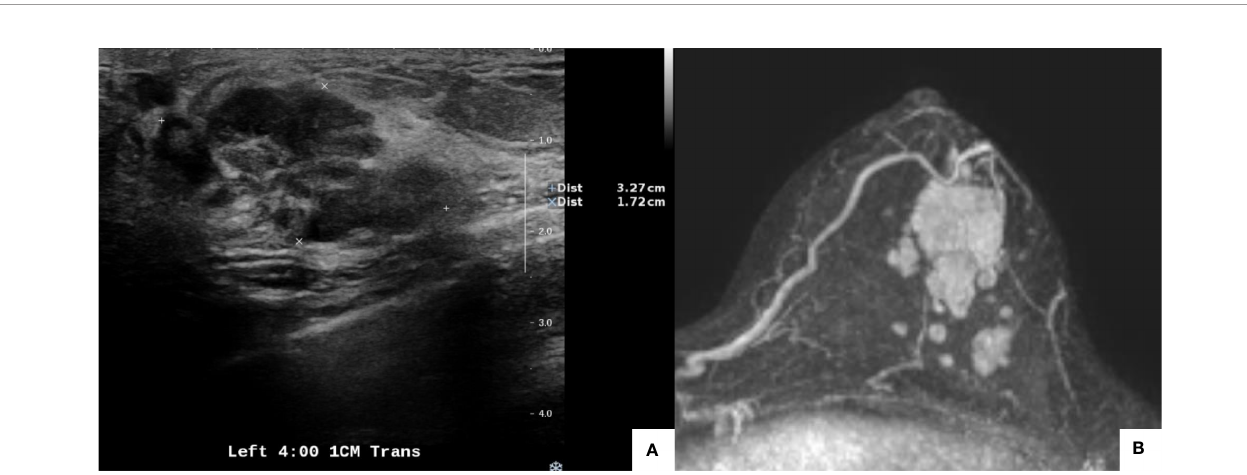
FIGURE 1 | Pretreatment imaging evaluation. Ultrasonography showed an irregular hypoechoic mass at the 4-o ’ clock position, 1 cm from the nipple, measuring 3.9 × 3.3 cm. Malignancy was con fi rmed with a biopsy (A) . Magnetic resonance imaging revealed a mass (3.4 × 2.2 cm) at the 4-o ’ clock position, 1 cm from the nipple in the left breast, which was concordant with the biopsy-con fi rmed malignancy. Multiple enhanced nodules (1.4 cm in the longest diameter) were observed, and the total extent measured 5.8 cm (B)